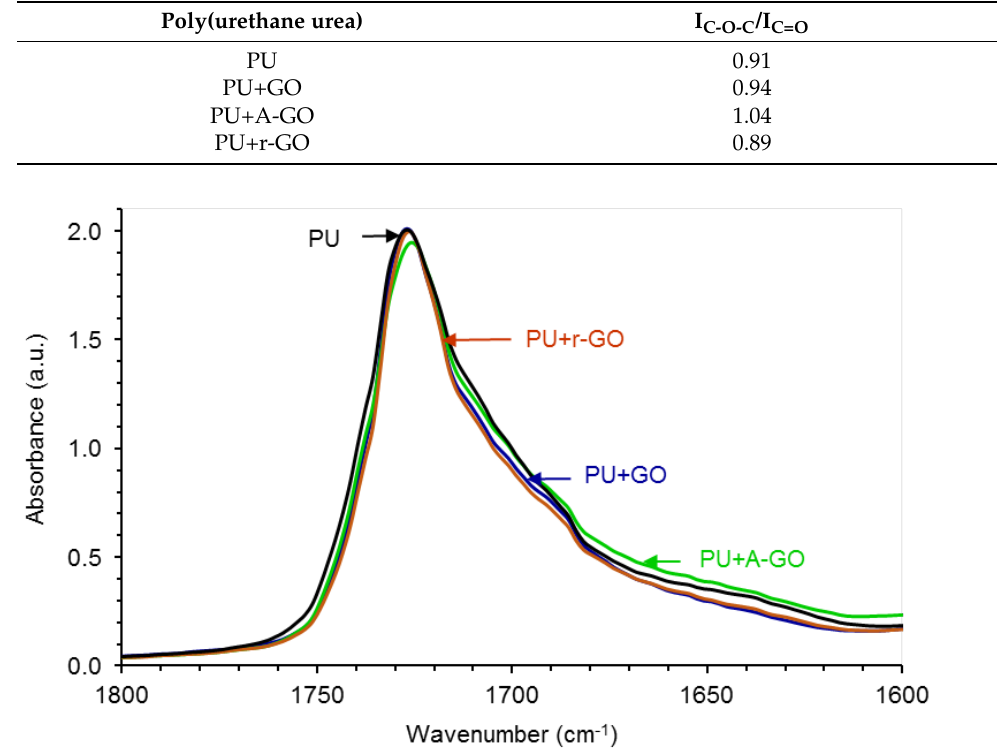
Figure 10. 1800–1600 cm − 1 region of the ATR-IR spectra of the PUs without and with GO derivatives. Figure 10. 1800 – 1600 cm −1 region of the ATR-IR spectra of the PUs without and with GO derivatives. Table 6. Relative contributions of the free and associated by hydrogen bond (H-bonded) urethane and urea species in the PUs. Curve fitting of the carbonyl region of the ATR-IR spectra. Relative Contribution of Species (%) Wavenumber (cm − 1 ) PU PU+GO PU+A-GO PU+r-GO 1727–1726 (free urethane) 1712–1708 (H-bonded